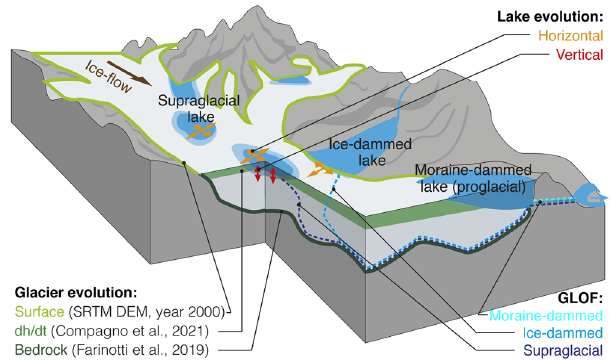
Fig. 1 Schematic overview of the different types of glacier lakes and the input data used in the present study. Data used for describing the glacier evolution are given in green. "dh/dt" stands for the ice thickness change rate. Glacier lakes are shown in blue, while red and orange arrows indicate their evolution. Dashed lines display possible lake drainage paths. Note that the study focuses on ice-dammed lakes (including supraglacial lakes). "GLOF" stands for Glacier Lake Outburst